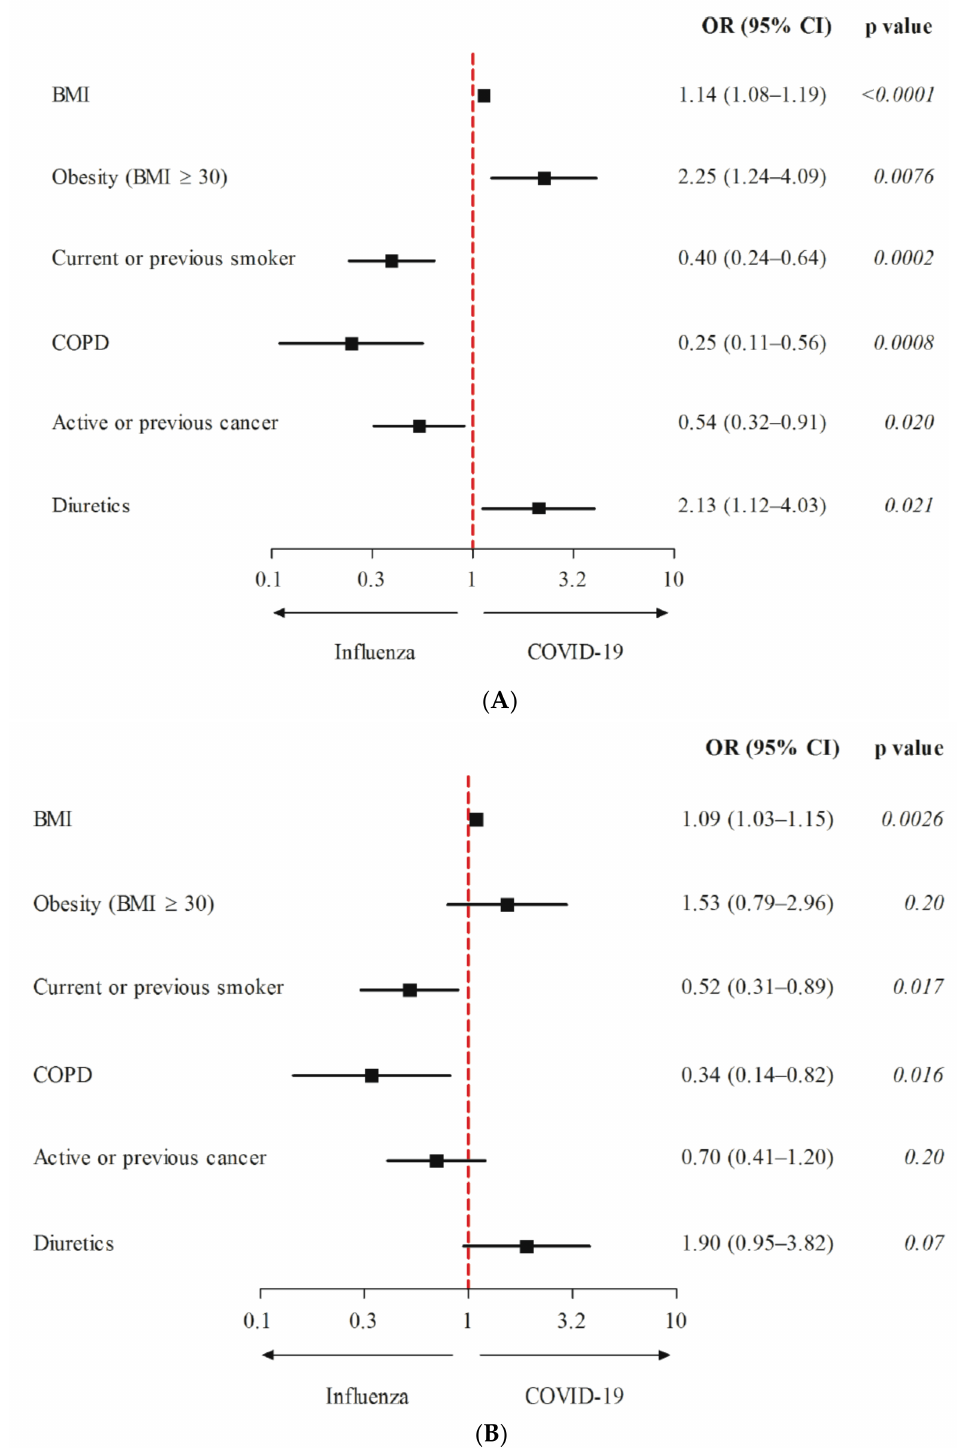
Figure 2. Representation of ORs between COVID-19 and influenza hospitalized patients. ( A ) ICU and non-ICU patients. ( B ) Non-ICU